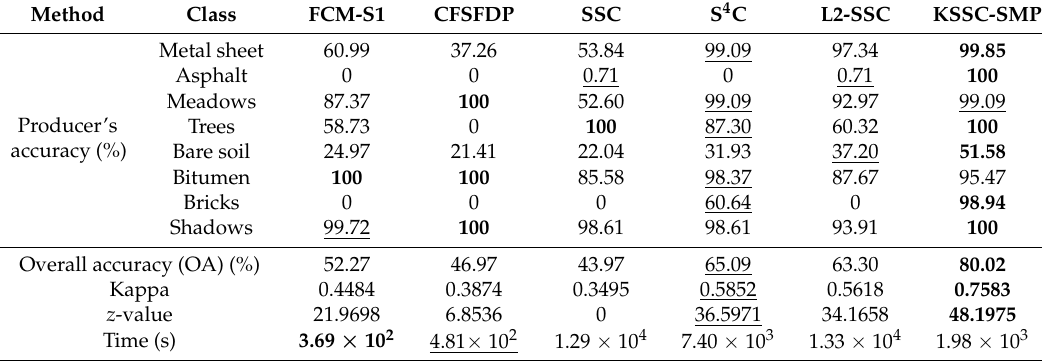
Table 6. Quantitative evaluation of the different clustering algorithms for the University of Pavia image. The best result in each row is shown in bold, with the second-best result